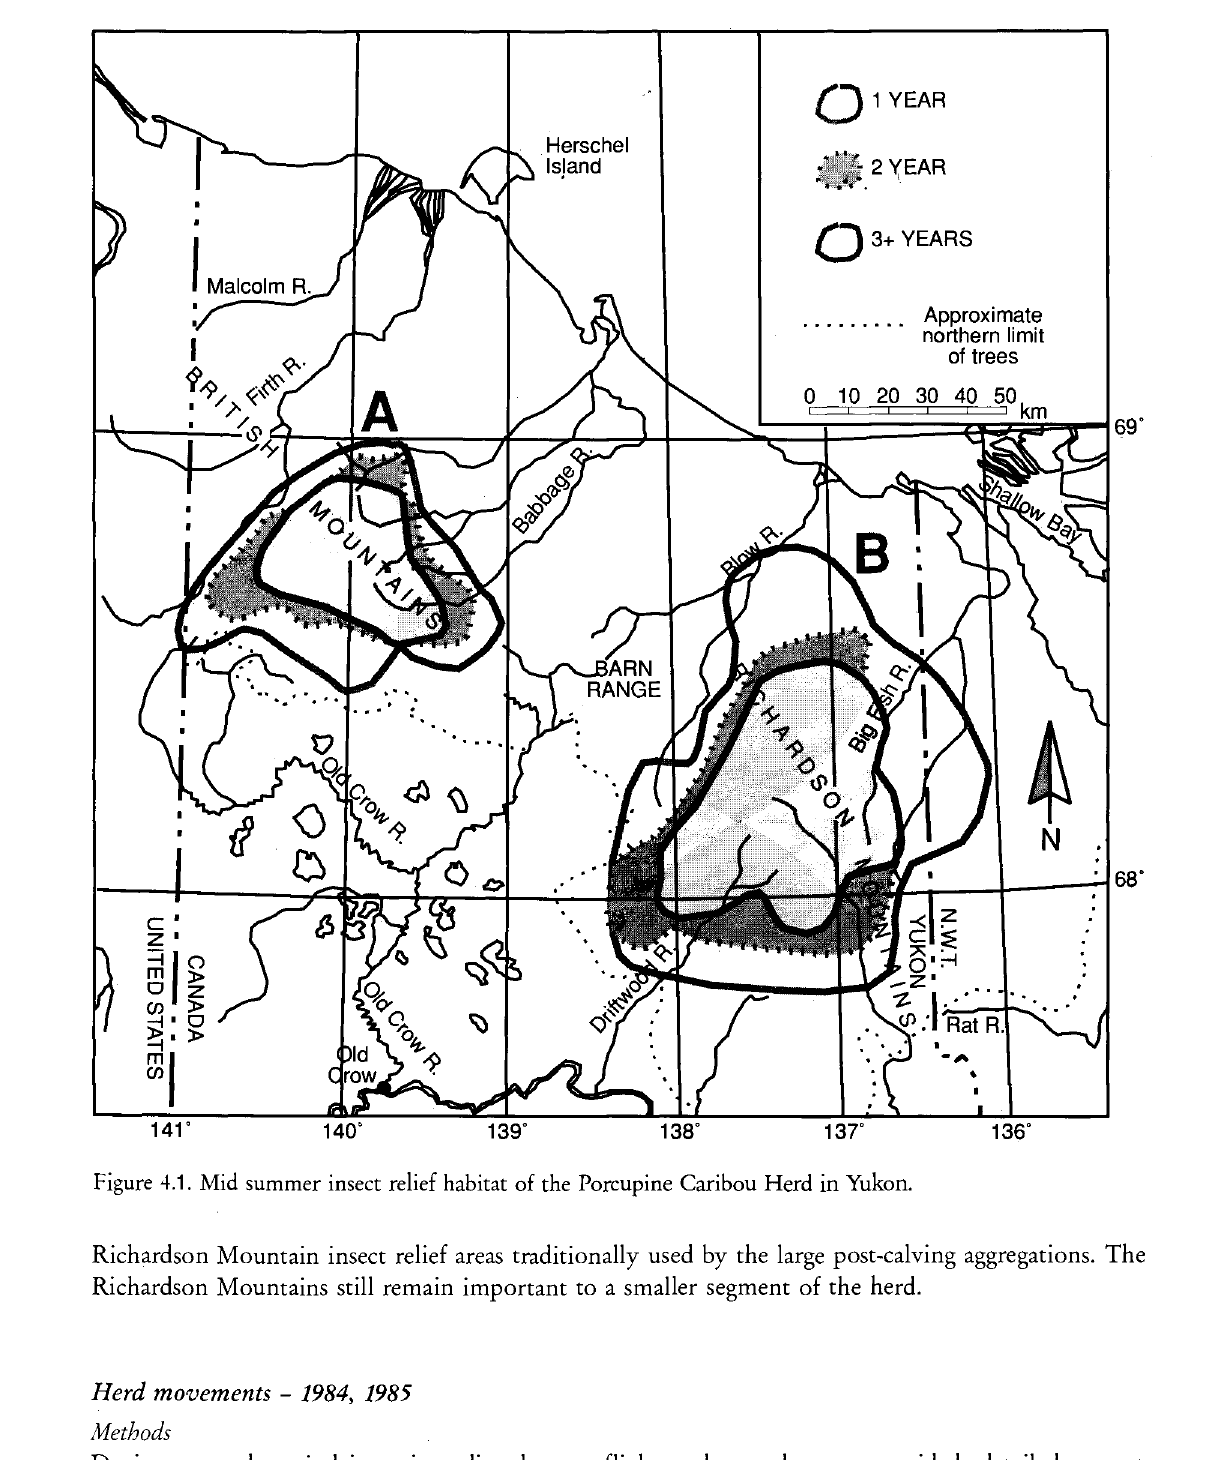
Figure 4.1. Mid summer insect relief habitat of the Porcupine Caribou Herd in Yukon. Richardson Mountain insect relief areas traditionally used by the large post-calving aggregations. The Richardson Mountains still remain important to a smaller segment of the